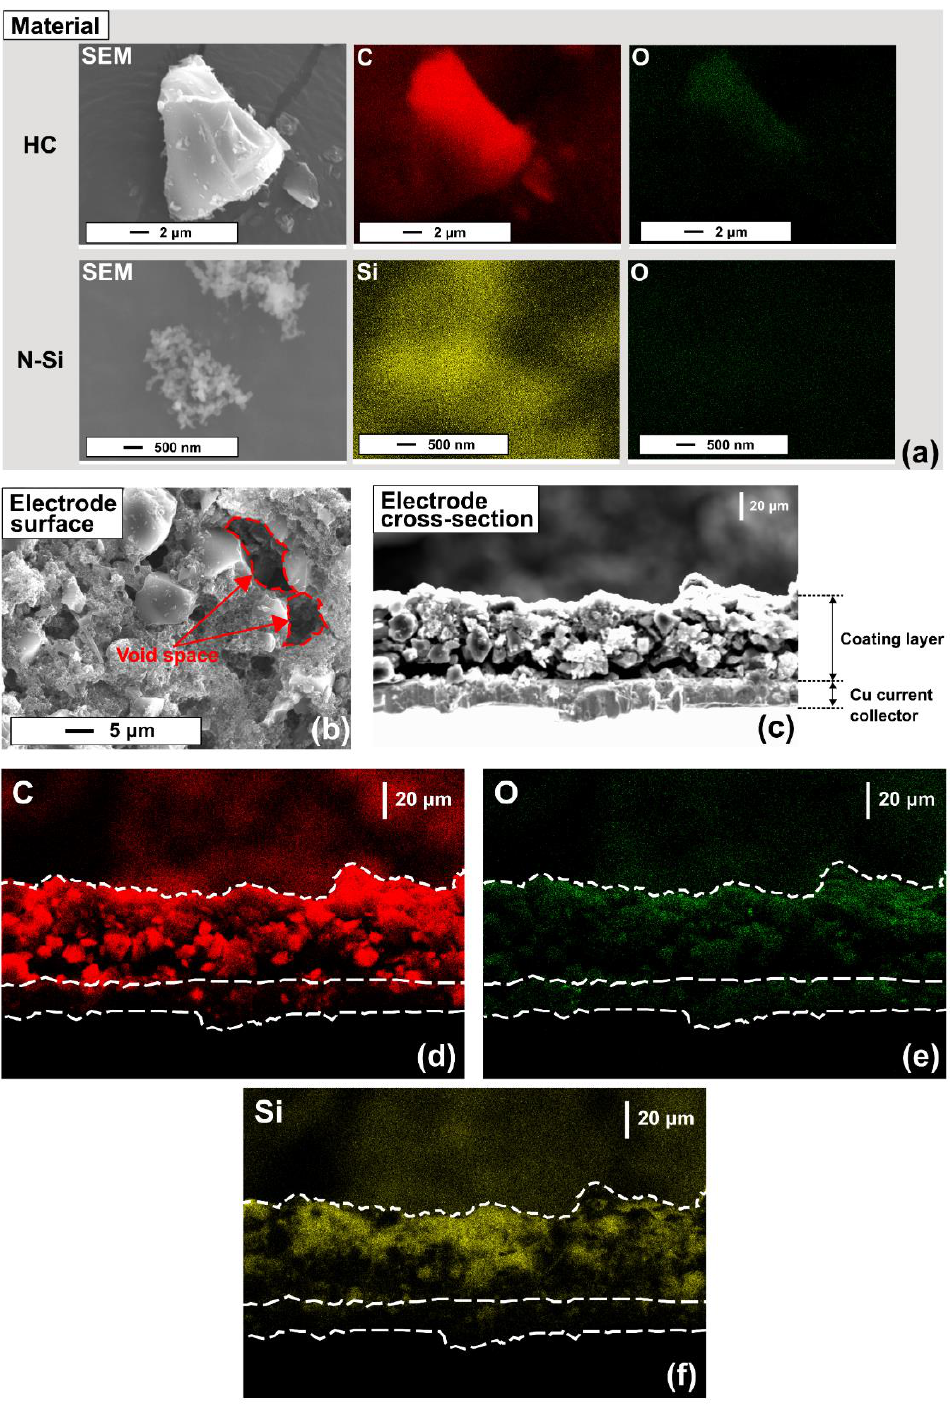
Figure 2. ( a ) SEM image and elemental mappings of HC and N-Si. SEM images of the ( b ) surface and ( c ) cross-section of the HC8/N-Si2 composite anode, and elemental maps of ( d ) C, ( e ) O, and ( f ) Si in the anode cross-section.